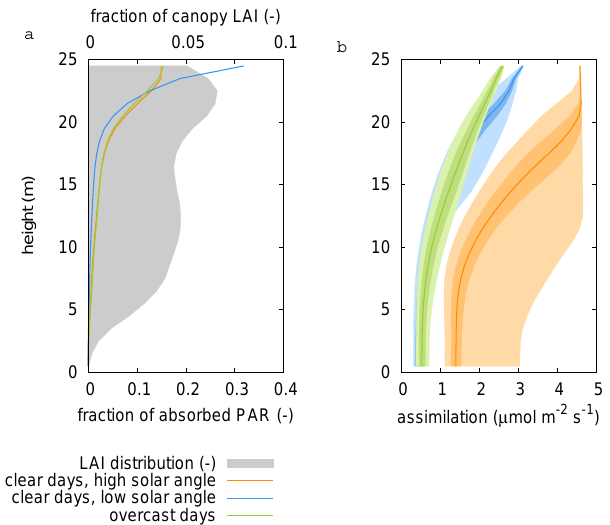
Figure 7. Vertical distribution of (a) light absorption and (b) CO 2 assimilation in the canopy (expressed per leaf area), separated for clear time steps ( f dif < 0 . 5) with a solar angle β > 30 ◦ ( n = 1418), clear time steps with a solar angle β < 30 ◦ ( n = 1382), and cloudy time steps ( f dif ≥ 0 . 5, n = 4888) for 1999. The average distribu- tion within a layer in (b) is represented by the median, 25–75% percentile, and 5–95%